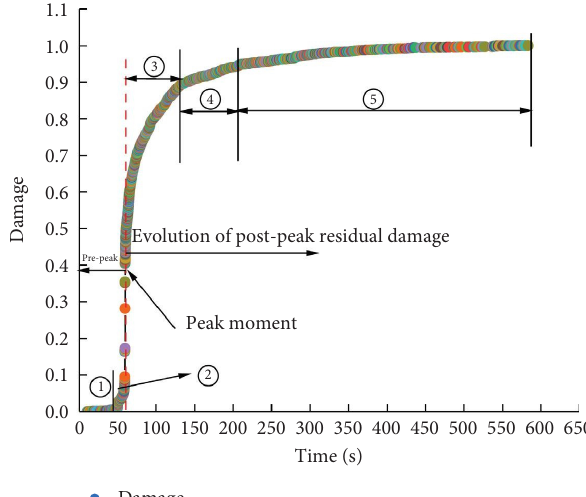
Figure 9: Te change law of damage variables characterized by acoustic emission characteristic parameters.